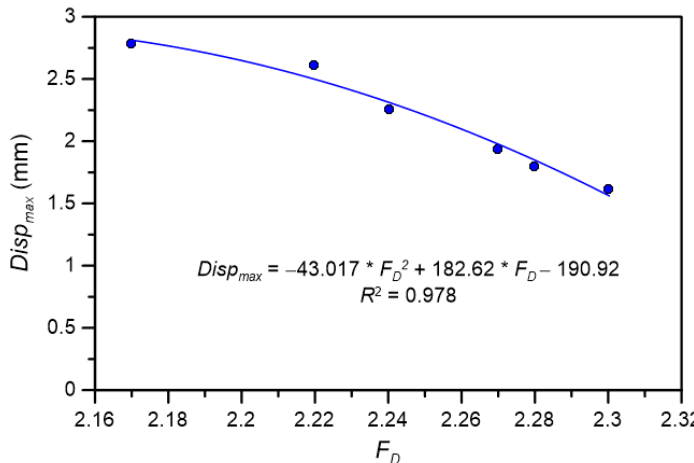
Figure 13. FOS vs. fractal dimension for experiment OT3.